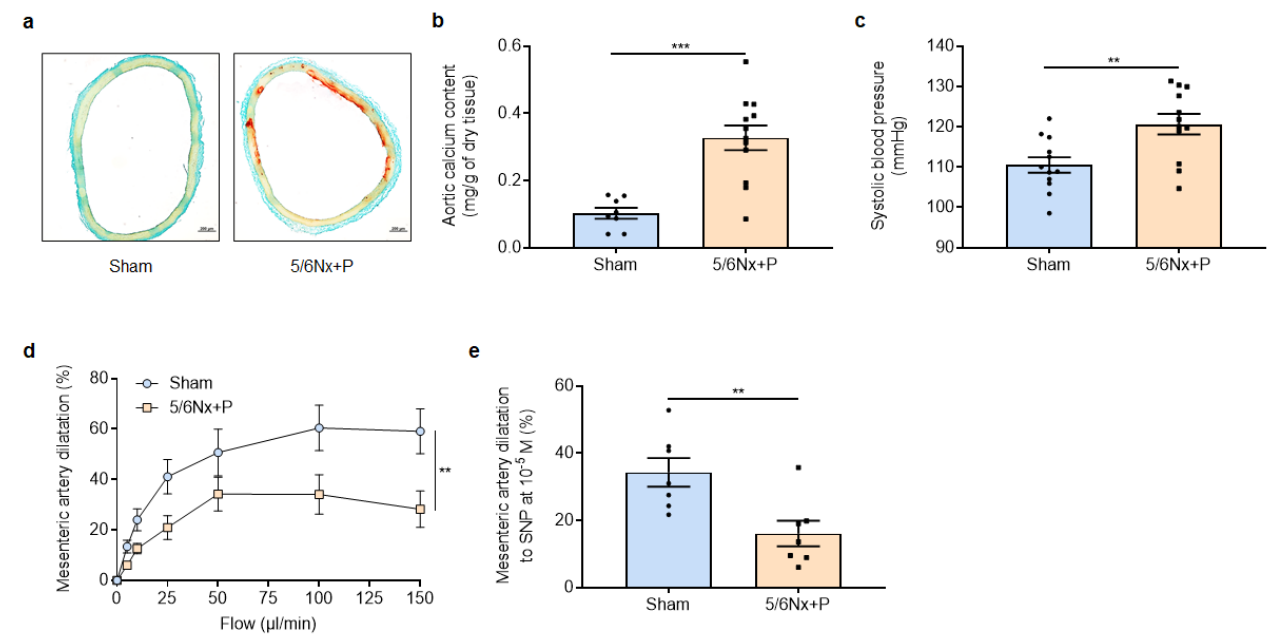
Figure 2. Representative images ( a ) and relative values of calcium content ( b ) of aortic rings stained with Alizarin red, systolic blood pressure ( c ), mesenteric artery endothelium-dependent dilatation to stepwise increase in flow ( d ), and endothelium-independent dilatation to 10 −5 M sodium nitro- prusside ( e ) obtained 10 to 11 weeks after surgery in sham-operated and 5/6 nephrectomized rats receiving a high-phosphate diet (5/6Nx + P). ** p <0.01, *** p < 0.001.